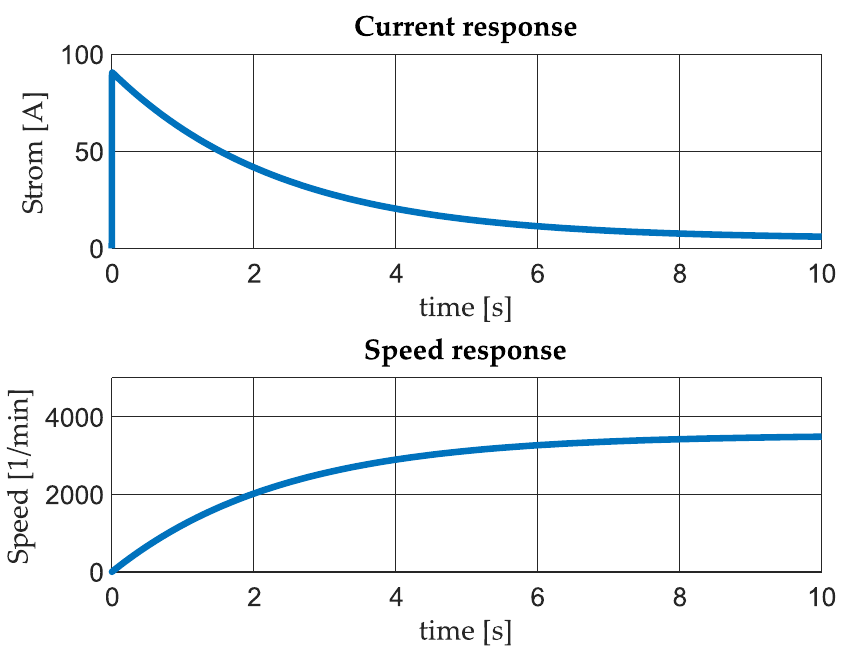
Figure 11. Step response as early dynamic evaluation